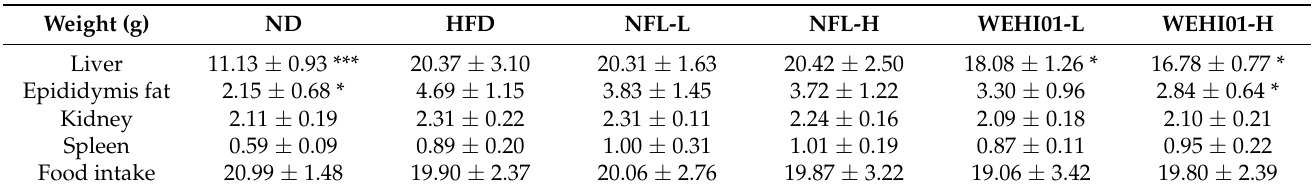
Figure 4. Effect of FLLS-WEHI01 on body weight in obese rats. ( a ) Body weight. ( b ) Body weight gain after 5 w. * p < 0.05, and *** p < 0.001 vs. HFD group. Table 1. Effect of FLLS-WEHI01 on liver, epididymis, kidney, and spleen fat weight as well as food intake in HFD-induced obese